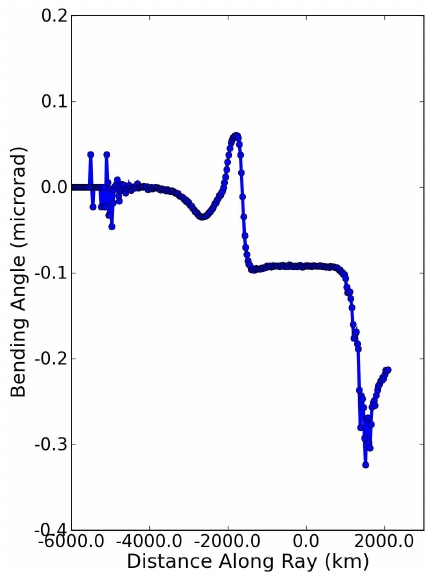
Fig. 8. Residual bending angle after the dual-frequency correction (Eq. 1) is applied, GAIM case. Compare to Fig. 5.